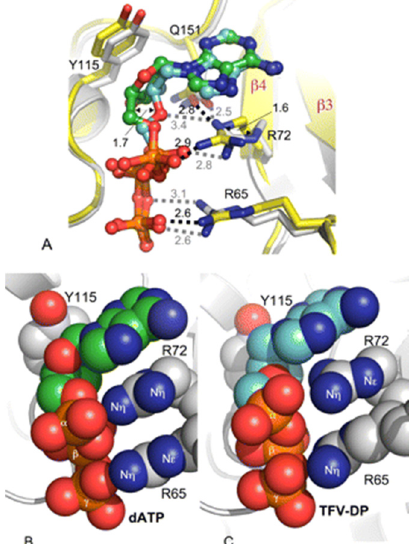
Figure 1. Comparison of binding of tenofovir diphosphate (TFV-DP) and dATP to K65R RT·dsDNA. A , overlay of TFV-DP (TFV-DP ( cyan ) and RT ( gray ) and dATP (dATP ( green ) with RT ( yellow )) shows that the structural difference between the inhibitor and the substrate at the deoxyribose moiety positions Arg72 and Arg65 side chains differently. The polar interactions are represented by dotted lines . Shown is stacking of the guanidinium plane of Arg65 and guanidinium plane of Arg72 and adenine base in K65R RT·dsDNA·dATP ( B ) and K65R RT·dsDNA·TFV-DP ( C ) ternary structures. Despite differences in the rotameric conformations of Arg65 and Arg72, the hydrophobic stacking is maintained in both structures. Reproduced from [29]